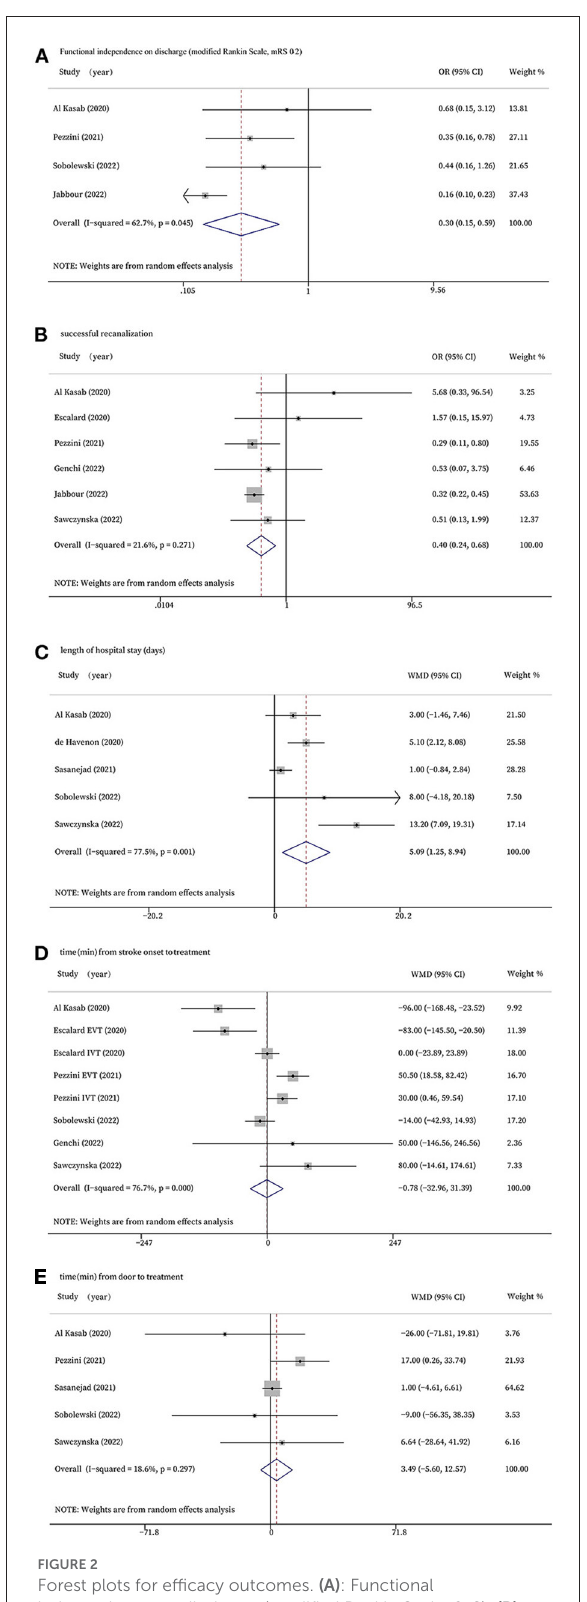
FIGURE2 Forest plots for efficacy outcomes. (A) : Functional independence on discharge (modified Rankin Scale, 0-2); (B) : successful recanalization; (C) : length of hospital stay (days); (D) : time (min) from stroke onset to treatment; (E) : time (min) from door to